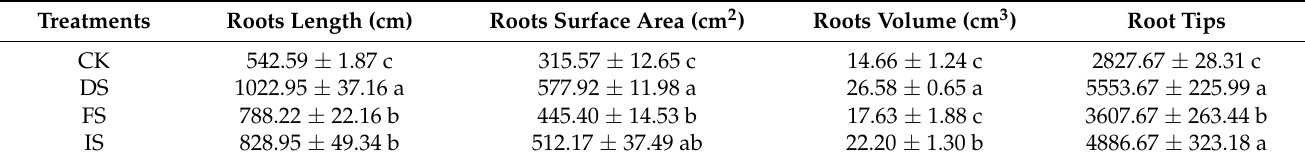
Table 3. Root growth of M. hupehensis seedling in soils biofumigated with different forms of Tateges erecta .